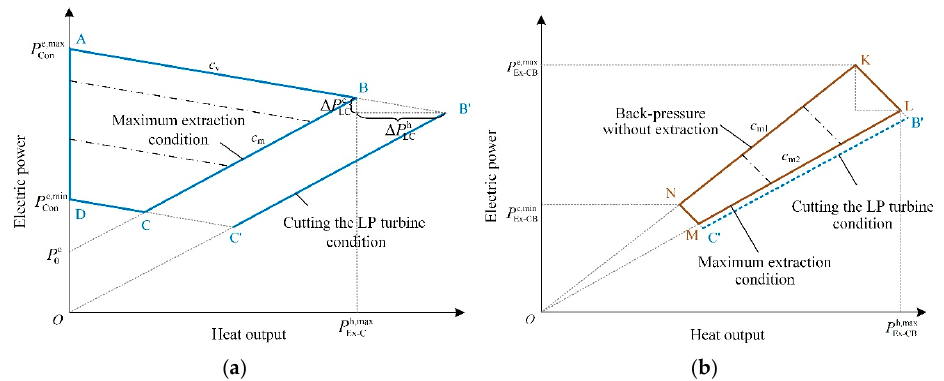
Figure 1. ( a ) The Feasible Operating Region (FOR) of extraction condensing unit; ( b ) FOR of extraction backpressure